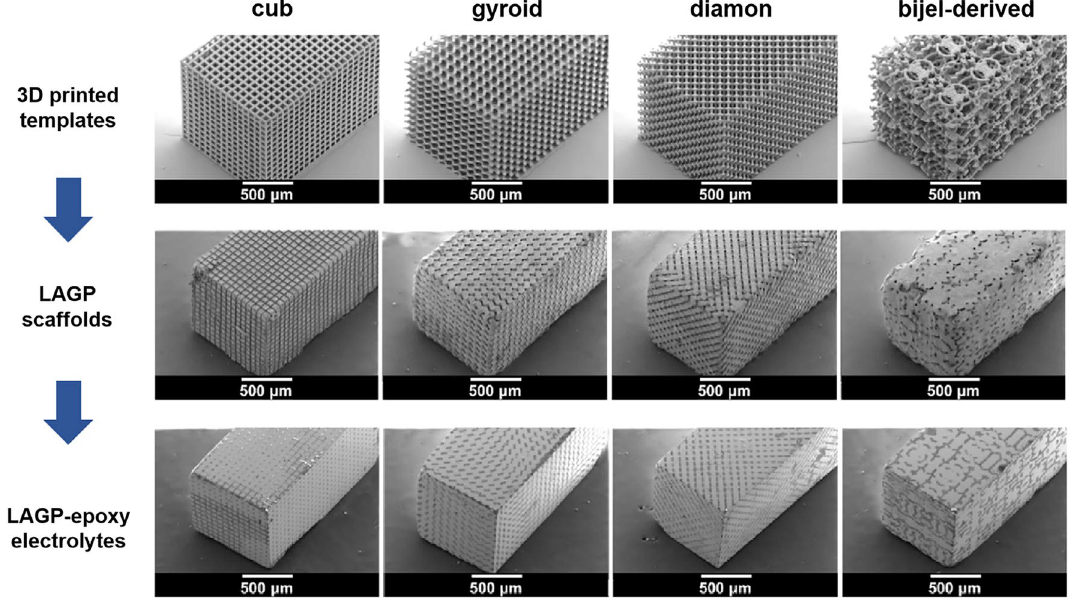
Fig. 5 SEM images of the 3D printed templates, the structured LAGP scaffolds and the structured LAGP-epoxy electrolytes with cube, gyroid, diamond and bijel-derived (left to right) microarchitectures. Reproduced with permission [134]. Copyright 2018, Royal Society of